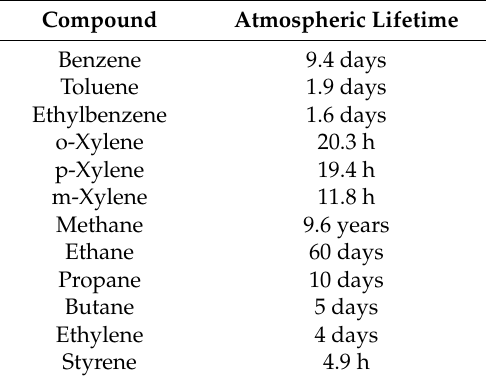
Table 3. Atmospheric Lifetime of some VOCs